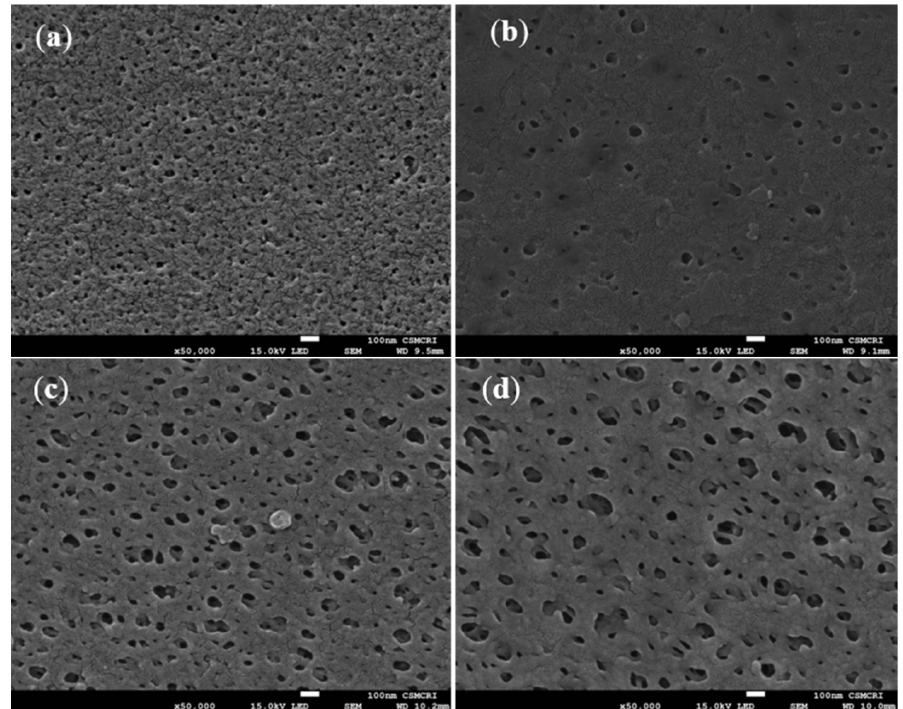
Figure 5. Scanning electron microscopy (SEM) revealed that pore size is directly proportional to diatom loading. SEM surface porosity images of ( a ) Polysulfone (PSf) with 0.0% of diatom, ( b ) PSf with 0.1 wt.% of diatom, ( c ) PSf with 0.2 wt.% of diatom, ( d ) PSf with 0.5 wt.% diatom ( × 50,000, 100 nm scale bar in all micrographs). Adapted from Paidi et al. [172]. Copyright (2022) MDPI.